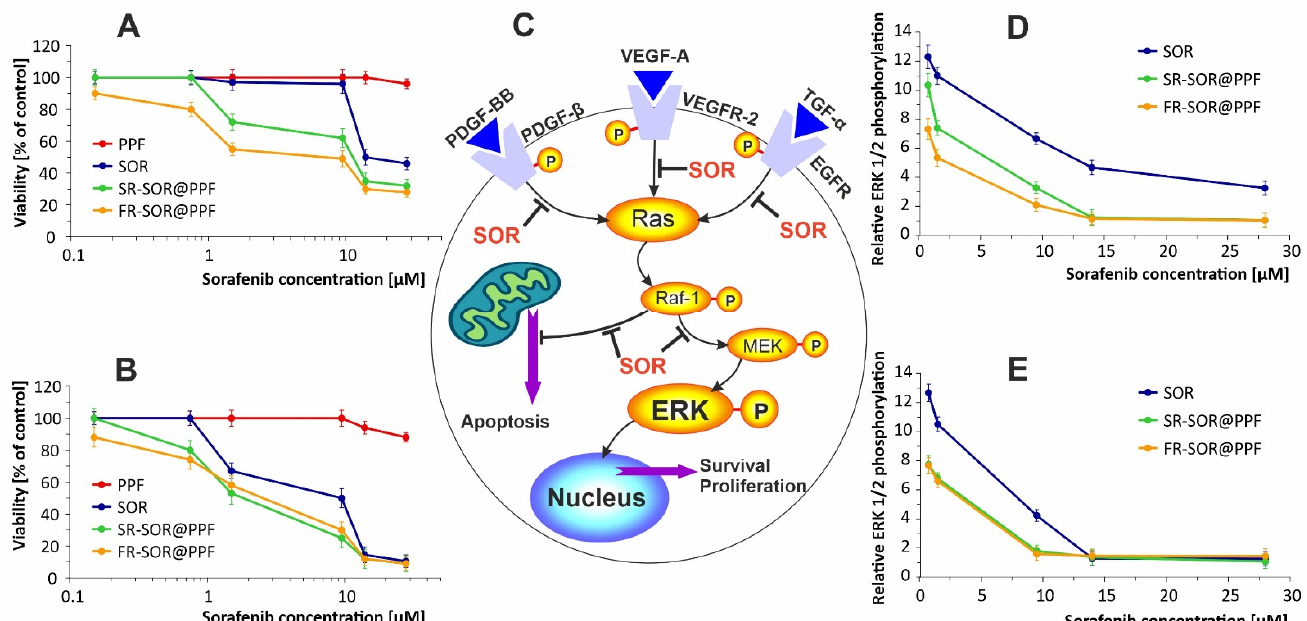
Figure 6. Viability of hepatoma cells after 24 h ( A ) and 72 h ( B ) of treatment with SOR, SR-SOR@PPF, and FR-SOR@PPF delivery systems. ( C )—schematic representation of SOR inhibited pathways. Relative ERK 1/2 phosphorylation level in hepatoma cells after 24 h ( D ) and 72 h ( E ) treatment. The values are normalized to protein content; note that the phosphorylation level of untreated cells was 12.3 ± 0.40 after 24 h, and 12.6 ± 0.38 after 72 h.